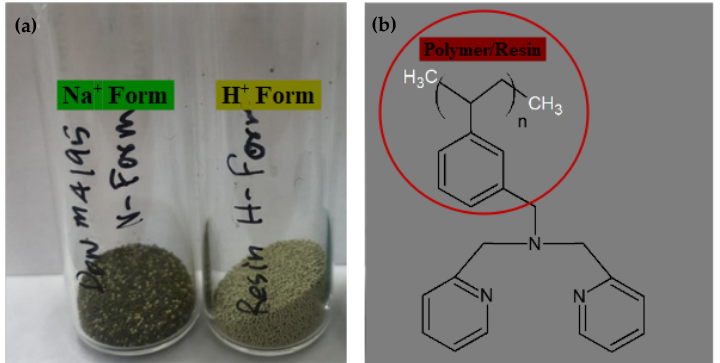
Figure 16. ( a ) Na + form and H + form Dowex-M4195 chelating resin and ( b ) the structure of polystyrene–divinylbenzene matrix, bispicolamine functional group or polymeric resin.